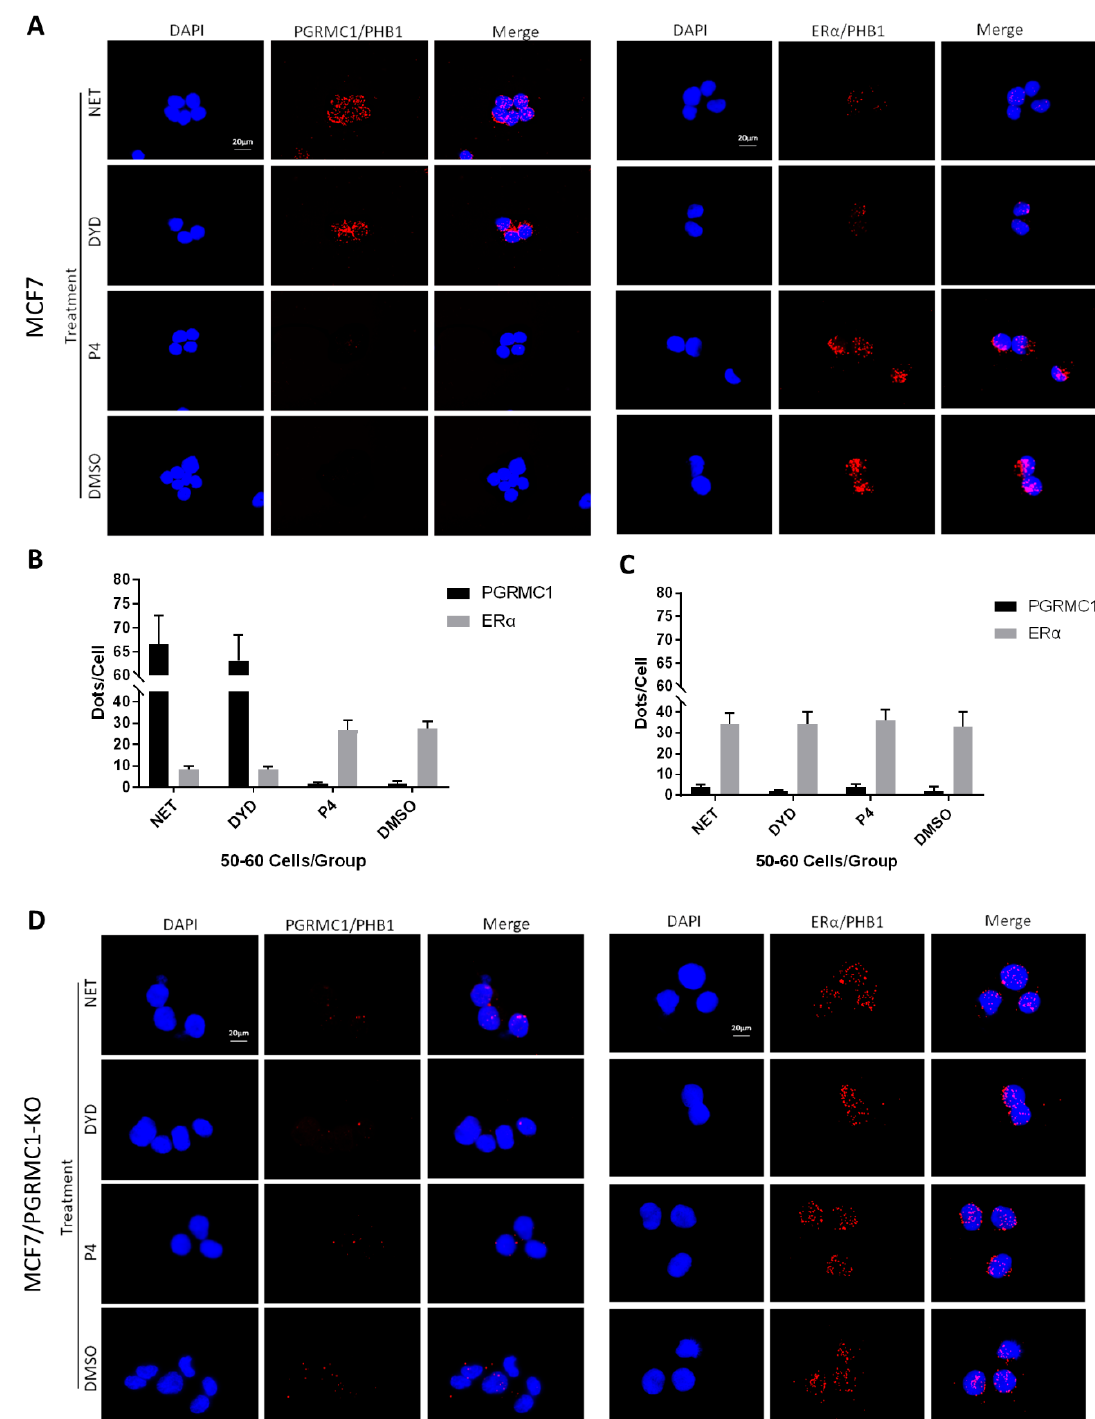
Figure 4. PGRMC1-PHBs interaction disturbs PHBs’ binding to ER α . ( A ) Proximity ligation assay (PLA) for PGRMC1- (or ER α -) interactions with PHB1 upon treatment with NET, DYD, P4 (10 − 6 M) and DMSO in MCF7 cells. Analysis of PLA for PGRMC1- (or ER α -) interactions with PHB1 in ( B ) MCF7 and ( C ) MCF7/PGRMC1-KO cells upon treatment with progestins and DMSO. Dots per cell were counted for 50-60 cells in each sample. Cell number and PLA signals were quantified using imageJ software. ( D ) PLA for PGRMC1- (or ER α -) interactions with PHB1 upon treatment with progestins and DMSO in MCF7/PGRMC1-KO cells. Each red spot represents a single interaction. Nuclear stain: DAPI. Magnification 40×.